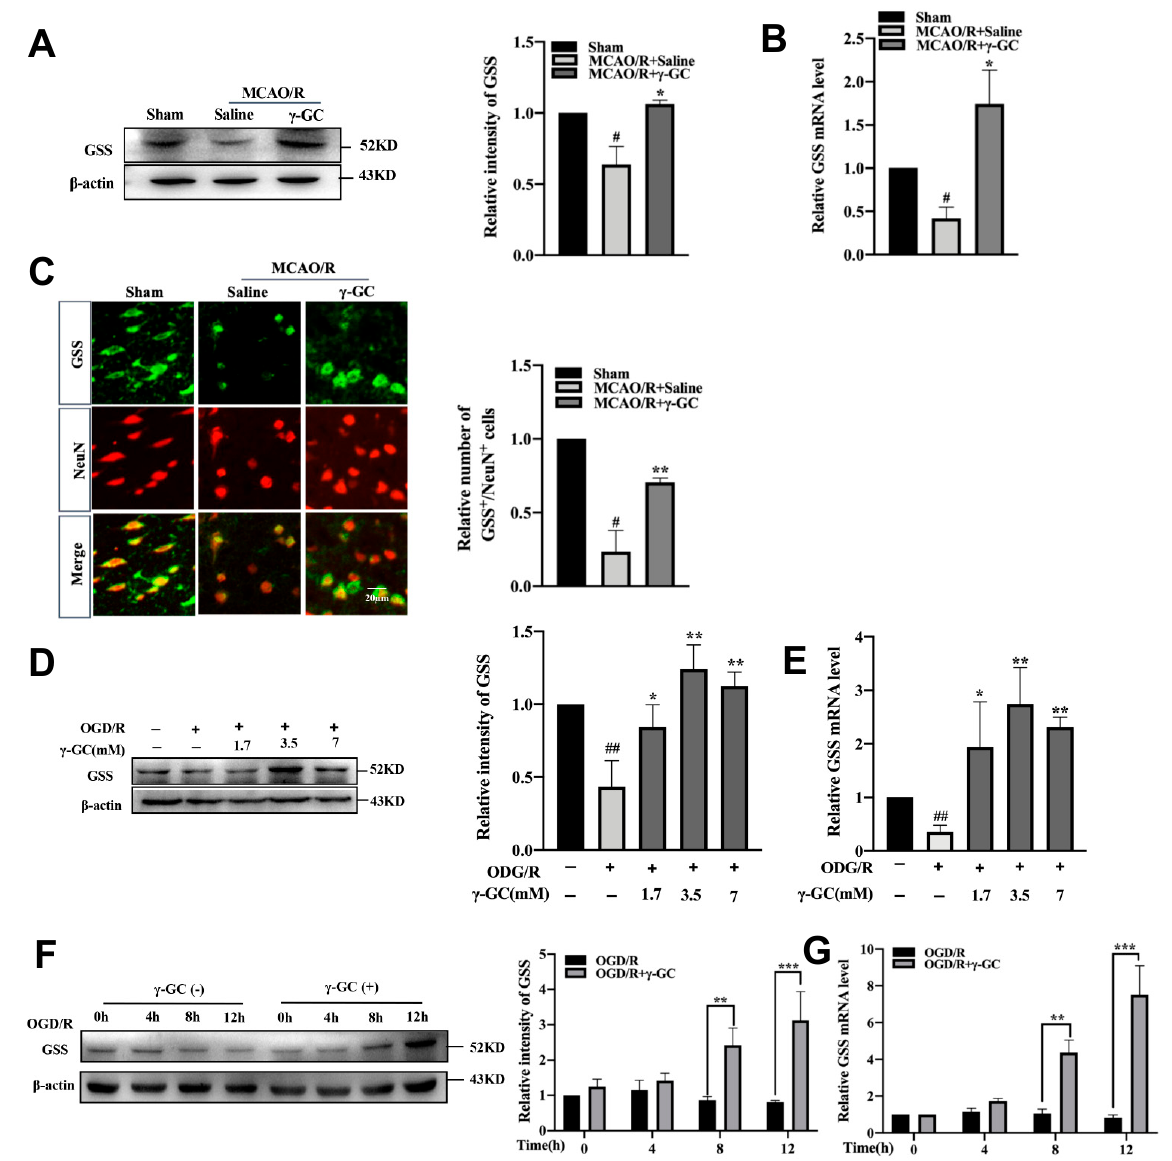
Figure 4. γ -GC increases neuronal GSS expression in vivo and in vitro. ( A – C ) Rats were treated with γ -GC (688 mg/kg body weight) 1.5 h after being subjected to MCAO (n = 3, 3 rats/group). Twenty- four hours after reperfusion, the following observations were performed. ( A , B ) The mRNA and protein levels of GSS were detected by qRT-PCR and immunoblotting assays, respectively. ( C ) Paraffin sections of the rat cerebral cortex were co-immunostained with GSS and NeuN antibodies, and the numbers of GSS + /NeuN + cells in the cortex were quantitatively analyzed (Scale bar, 20 µ m). PC12 cells were treated with OGD for 4 h (n = 3), and γ -GC (1.7, 3.5 and 7 mM) was added into the cell culture at the onset of reoxygenation. ( D , E ) Twelve hours after reoxygenation, the mRNA and protein levels of GSS were detected by qPCR and immunoblotting. ( F , G ) PC12 cells were treated with γ -GC (3.5 mM) for the indicated time after reoxygenation, and then mRNA and protein levels of GSS were detected by qRT-PCR and immunoblotting assays, respectively. Data are mean ± SD, # p < 0.05 and ## p < 0.01 versus Sham group or control cells; * p < 0.05, ** p < 0.01 and *** p < 0.001 versus MCAO/R group or OGD/R